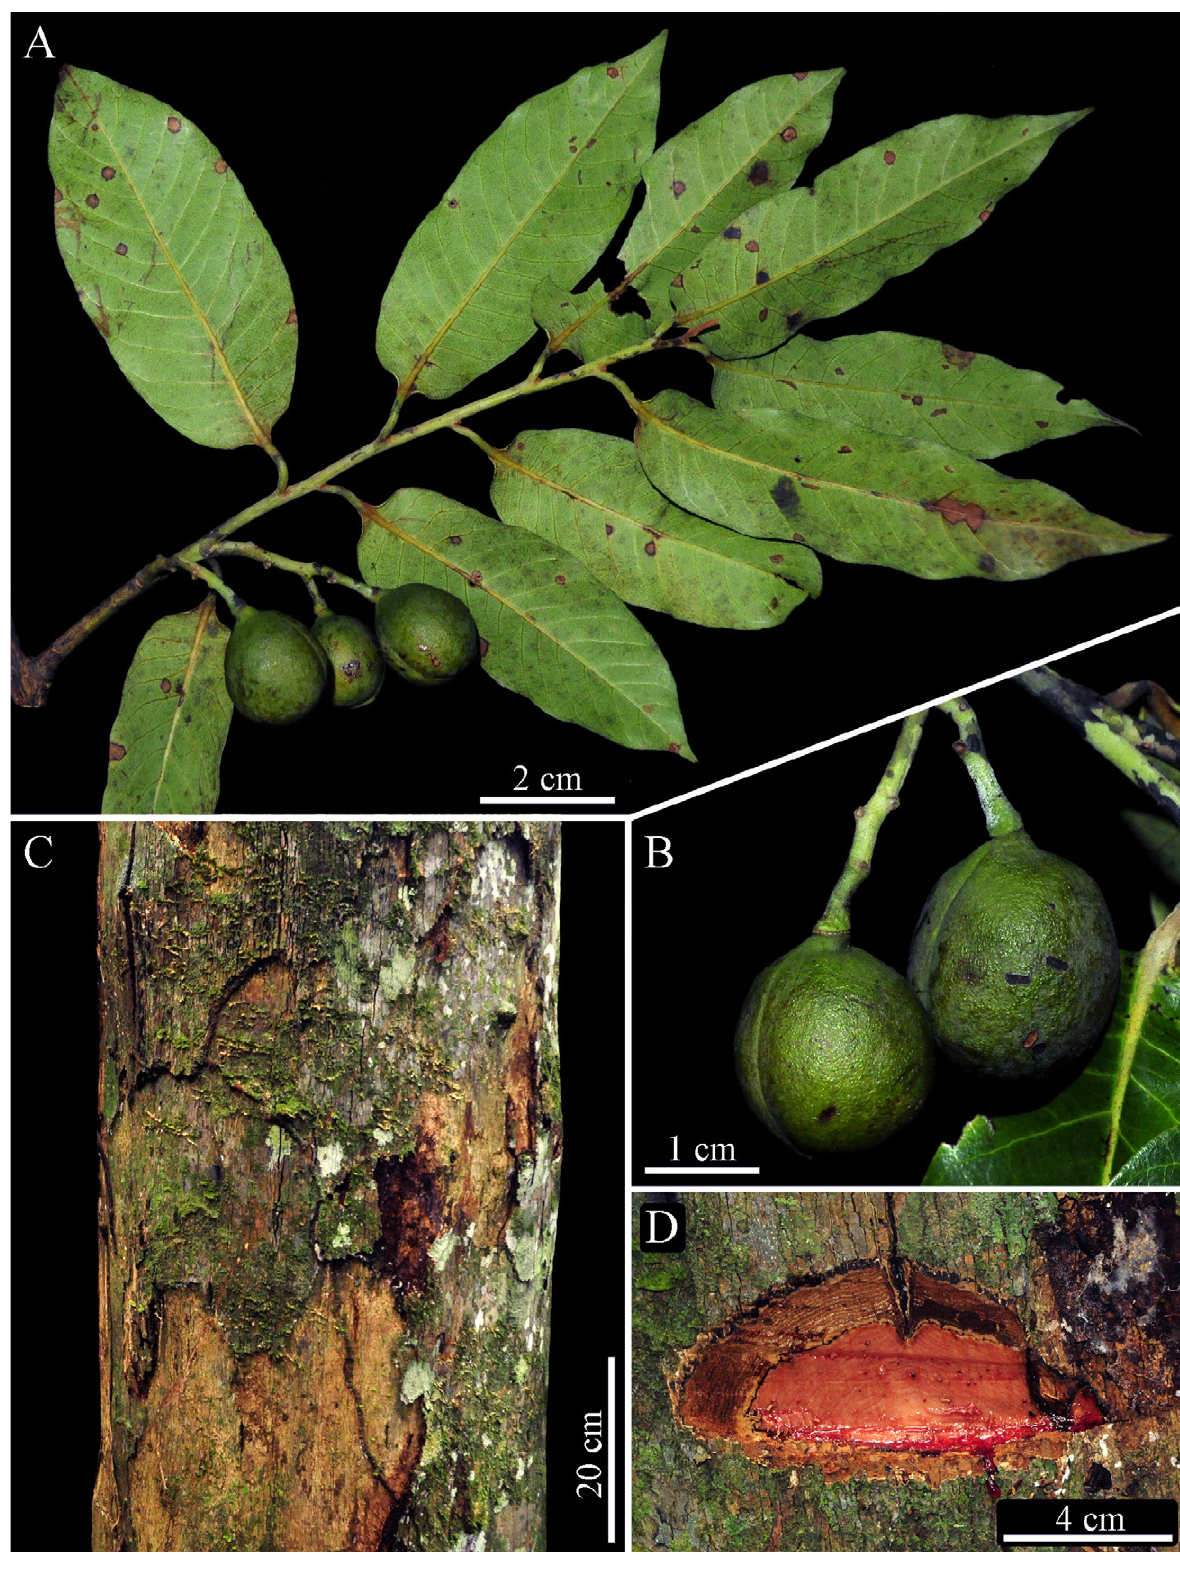
Figure 7. Virola gardneri (A DC.) Warb. A. Branch with immature fruits and abaxial leaves surface. B. Immature fruits in the final stage of development. C. Bark appearance. D. Slash